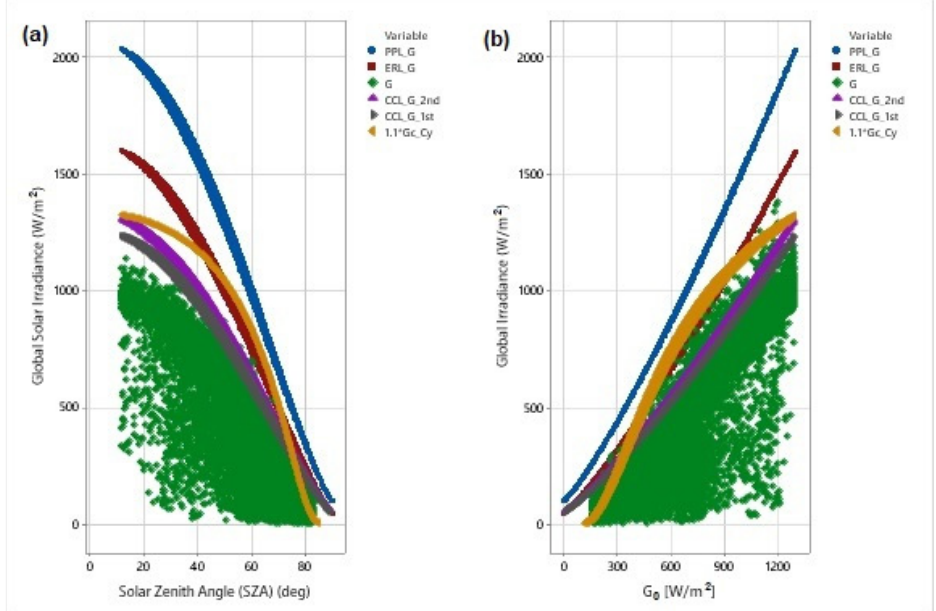
Figure 6. ( a ) graphical representation of PPL, ERL and CCL tests of the average 10 min irradiances of the pyranometer on solar tracker ( G ) as a function of solar zenith angle (SZA); and ( b ) graphical representation of PPL, ERL and CCL tests of the maximum 10 min irradiances of the pyranometer on solar tracker ( G ) as a function of extraterrestrial irradiance at the top of the atmosphere ( G 0 ).